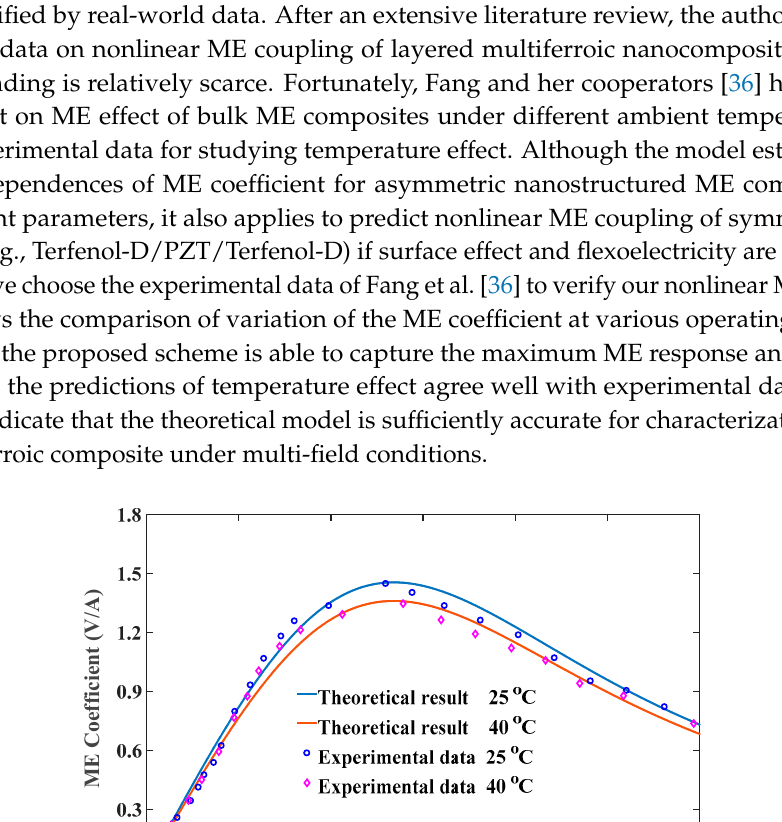
Table 1. Material constants of FE and FM materials.